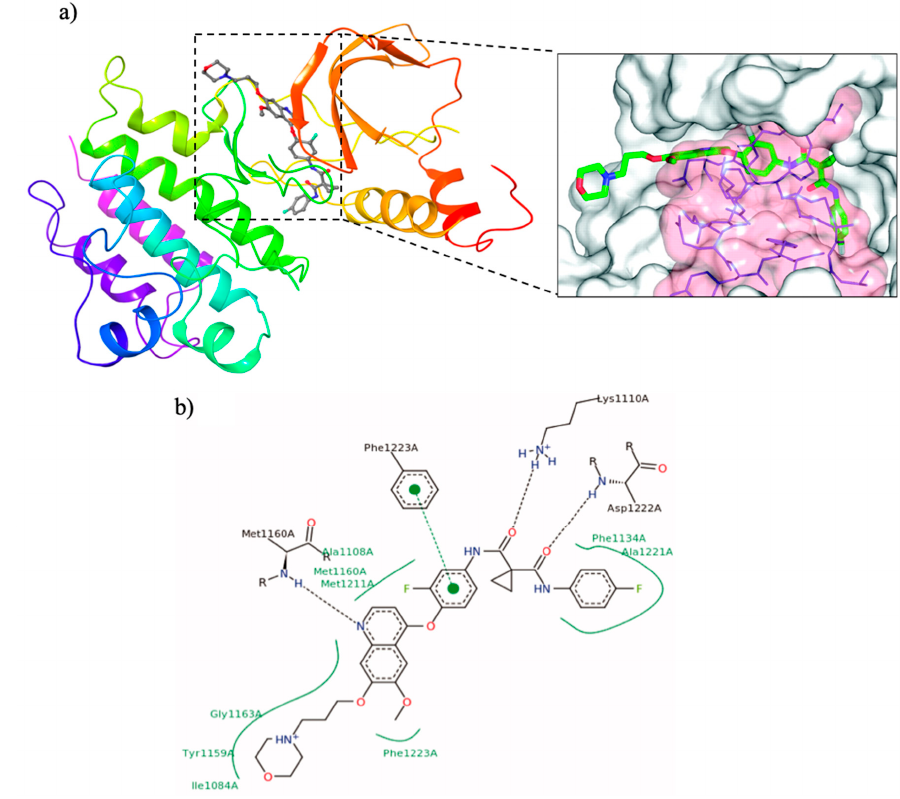
Figure 4. ( a ) crystal structure of kinase domain of c-Met in complex with foretinib (PDB ID: 3LQ8). In the box the binding cavity of the receptor occupied by the quinoline small molecule is illustrated (the activation loop is represented with transparent surface) [31]; ( b ) interactions of foretinib with amino acid residues of the c-Met active site [32].